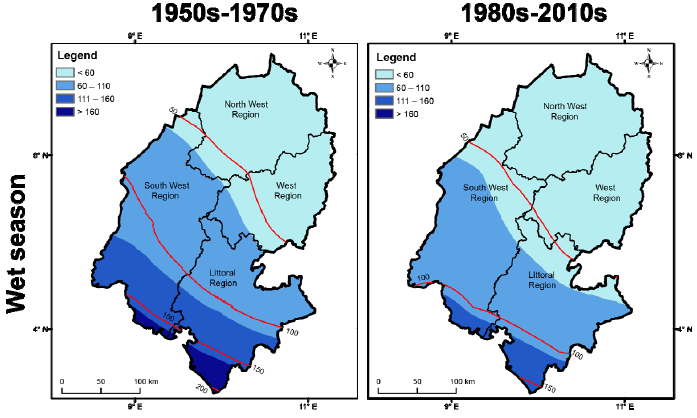
Figure 9. Spatial distribution of mean rainfall for the western regions of the country (Littoral, North- West, West, and South-West) at seasonal and annual time scales, between the decades 1950–1970 and 1980–2010.